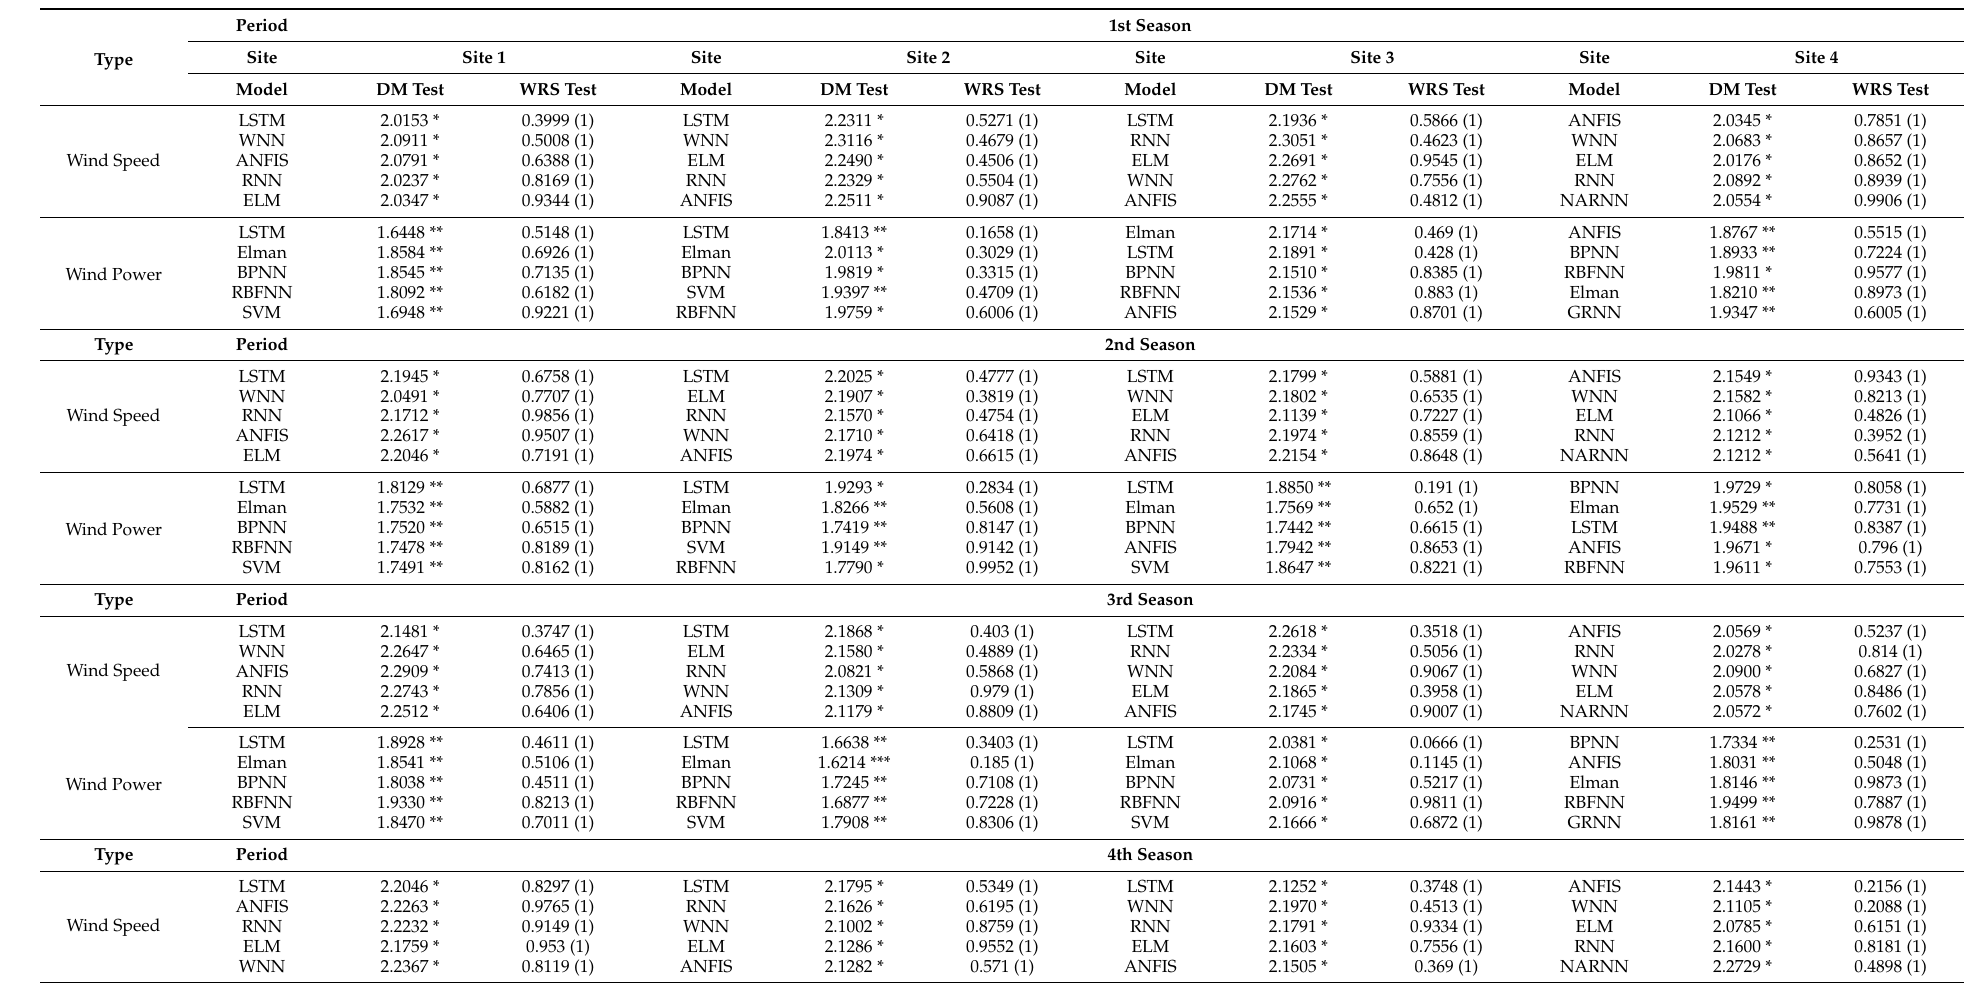
Table A5. The test result of two types of time series by each